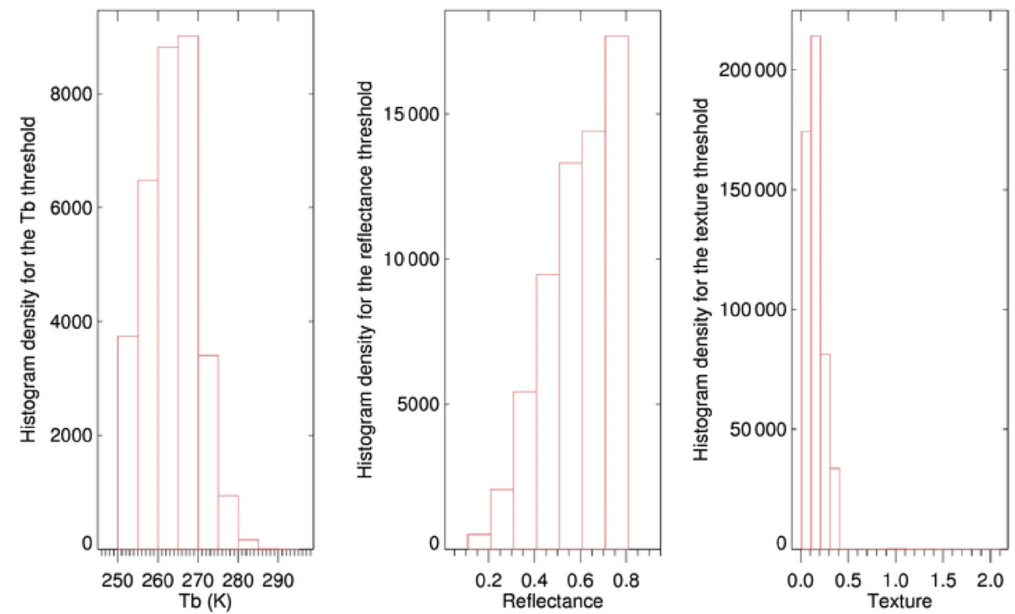
Figure 11. Histograms of T b , reflectance, and texture values if a pixel was assigned to be convective by MRMS, but not detected by the mature cloud detection method due to each of the